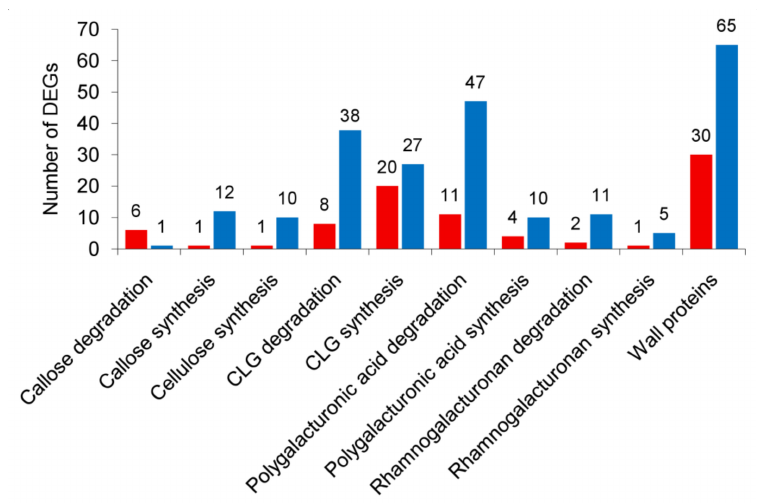
Figure 8. The number of the plant cell wall-related genes differentially expressed in potato plants infected with Pectobacterium atrosepticum compared to non-infected plants. Red bars are for the upregulated genes, while blue bars are for the downregulated genes. CLG—cross-linking